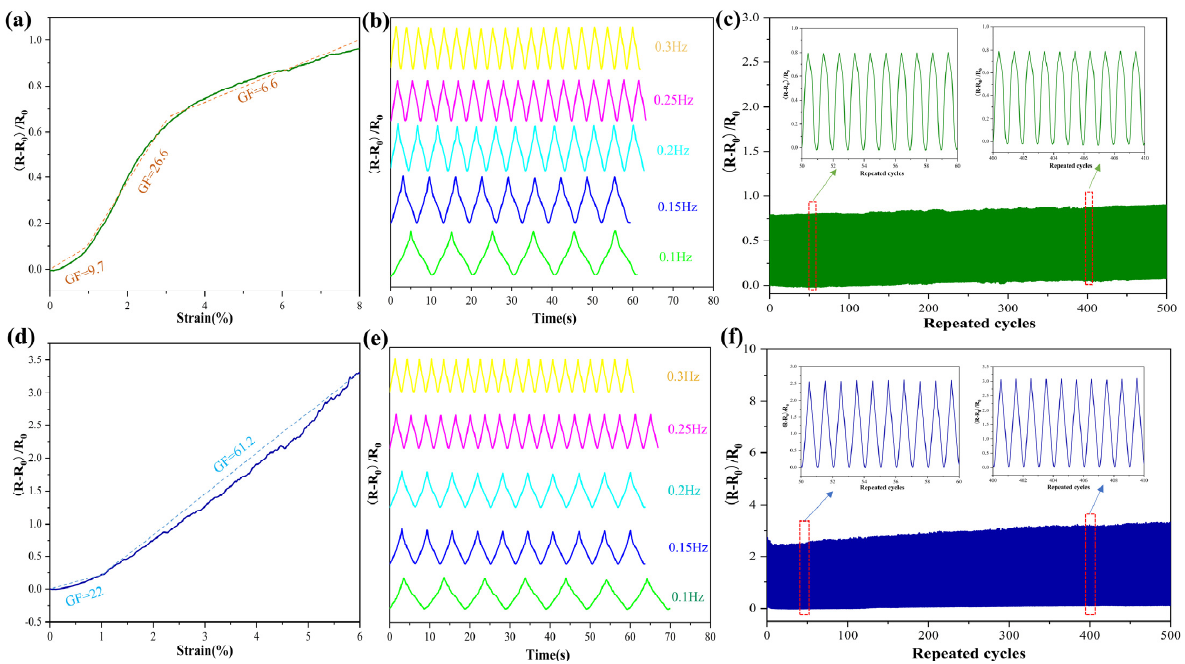
Figure 4. Relative resistance variation of the PMPF sensor to the corresponding applied strain in the ( a ) course direction and ( d ) wale direction. Relative resistance changes at different frequencies of 0.1 to 0.3 Hz due to stretching and releasing in the ( b ) course direction and ( e ) wale direction. Performance of the sensor under 500 cycles of tensile loading in the ( c ) course direction and ( f ) wale direction.